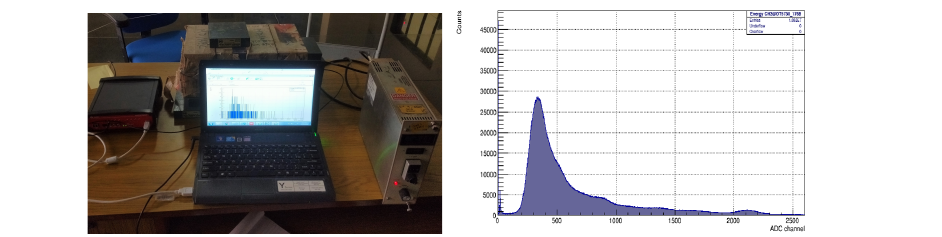
Figure 3. (Left) Experimental setup when Detector was shielded by lead bricks. (Right) CoMPASS DAQ software interface during background measurement at beam hall by detector 2.